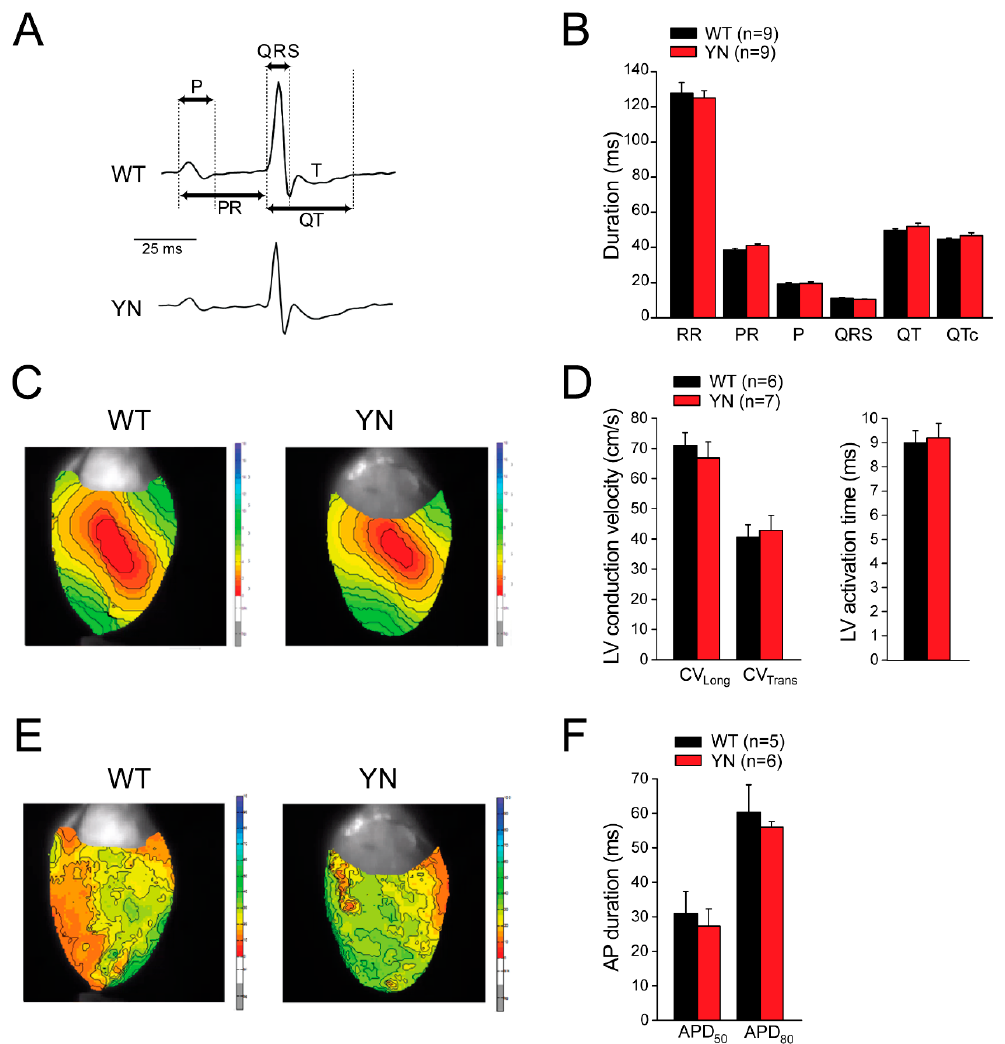
Figure 4. Surface ECG measuraments and optical mapping in isolated Langendorff-perfused mice hearts. ( A ) Typical surface ECG recordings in wild-type (WT) and Scn5a- p.Y1981N (YN) mice. Arrows indicate how the various ECG intevals were measured. RR intervals were defined as the interval in ms between two consecutive R waves. ( B ) Average data for ECG parameters. No differences were observed between WT and YN mice ( n indicates number of mice). ( C ) Typical left ventricular (LV) activation maps from an isolated WT and YN mouse heart paced at a cycle length of 120 ms.( D ) Average LV longitudinal (CV long ) and LV transversal (CV trans ) conduction velocity and LV activation time in WT and YN hearts. ( E ) Typical examples of LV activation maps from an isolated WT and YN mouse heart during stimulation at a cycle length of 150 ms. ( F ) Average values for action potential duration (APD) at 50% and 80% repolarization (APD 50 and APD 80 ) in WT and YN hearts. n indicates number of mice.